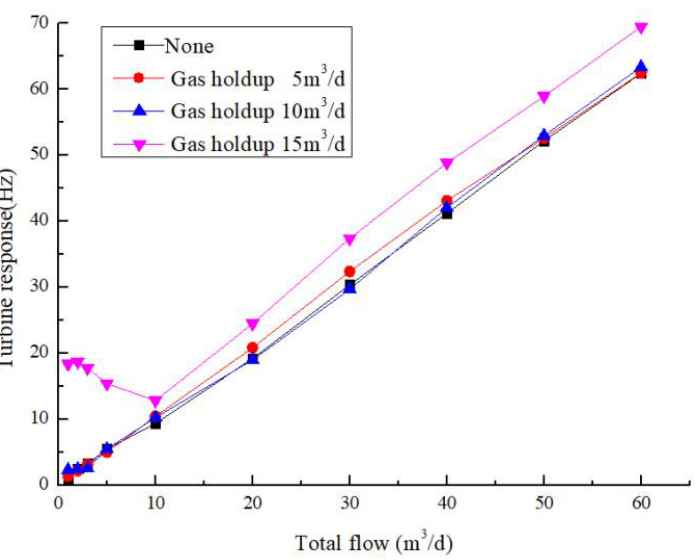
Figure 17. Output frequency curve of turbine flowmeter with different gas phase flow in pure water.